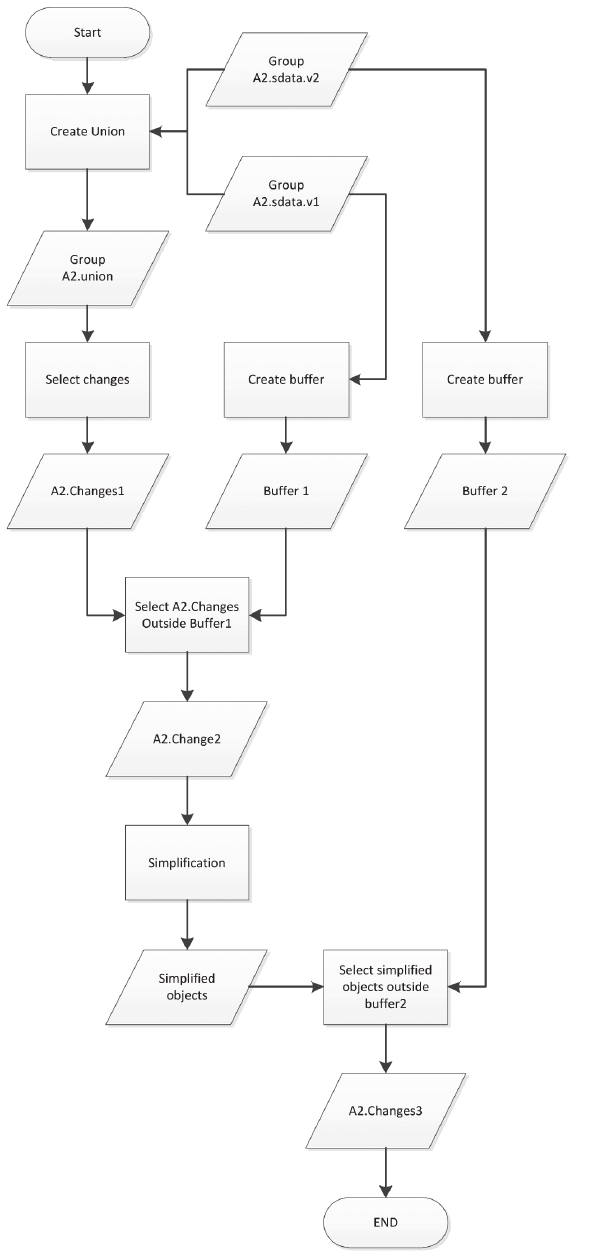
Fig. 7. The processes for determining significant changes in the geometry of spatial